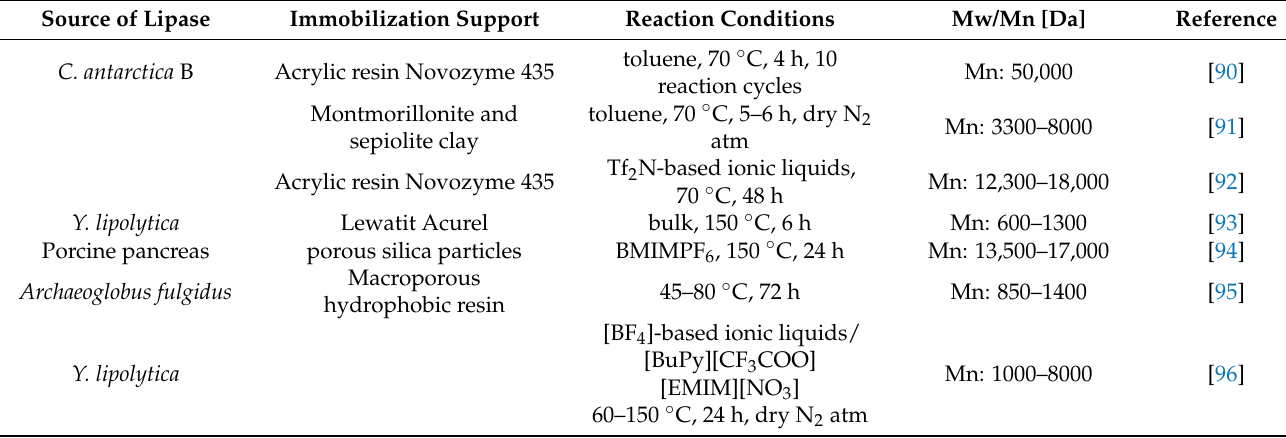
Table 1. Synthesis of poly-( ε -caprolactone) catalyzed by